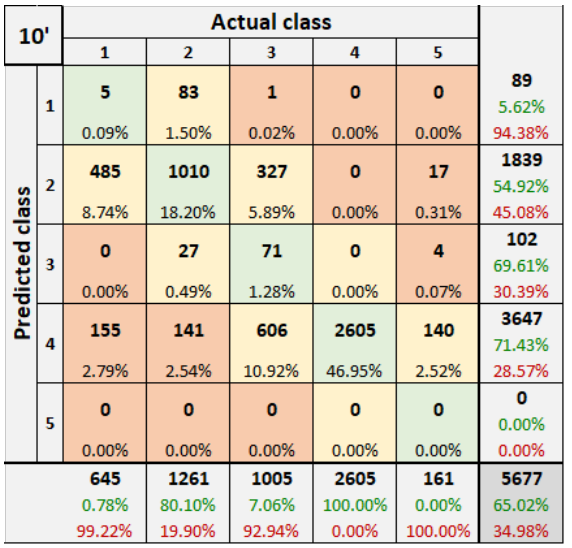
Figure 7. Confusion matrix corresponding to a time horizon of 10